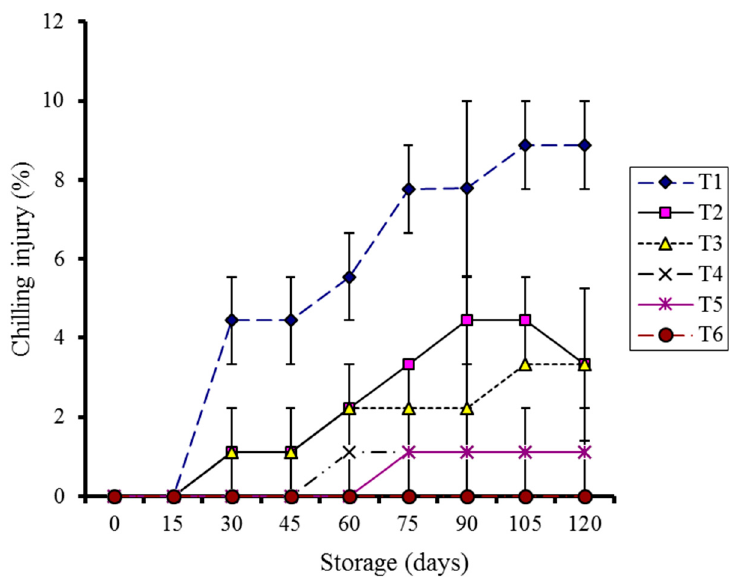
Figure 2. Effect of CMC and guargum-based silver nanoparticle coatings on the chilling injury of kinnow fruit stored at 4 and 10 °C during storage. The vertical bars represent standard error of the means. Values represented as mean ± SE of three replicates.